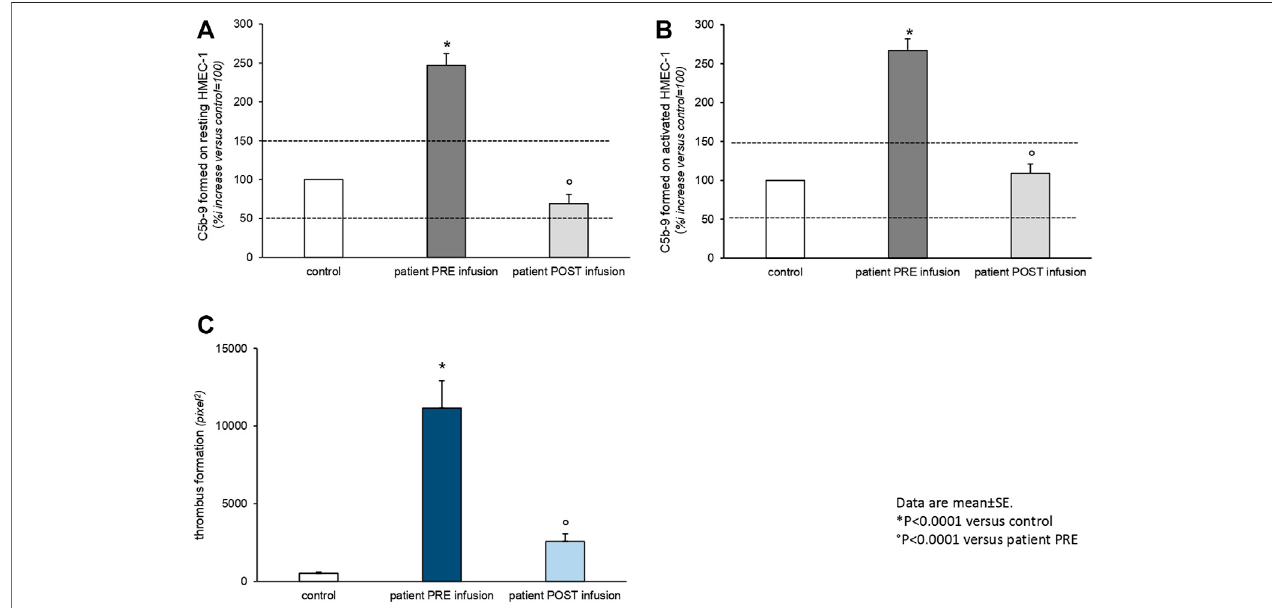
FIGURE 2 | Ex vivo C5b-9 deposition (A,B) and thrombus formation (C) on the cultured human microvascular endothelial cell (HMEC-1) line induced by serum of Patient2collectedbefore(PREinfusion)and10 daysafter(POSTinfusion)eculizumabtreatment. (A,B) .HMEC-1resting (A) oractivatedwithADP (B) wereincubatedfor 2 hwithserum(diluted1:2withtest medium,HBSS with0.5%BSA)fromthepatient orwithacontrolserum pool. Attheendofincubation, thecellswerewashed, fi xed, and stained with rabbit anti-human complement C5b-9 complex antibody followed by the FITC-conjugated secondary antibody. Fluorescence microscopy was used to view the fl uorescent staining on the endothelial cell surface, and the HMEC-1 area covered by C5b-9 staining was calculated by automatic edge detection (ImageJsoftware)in15high-power fi elds.Foreachsample,thehighestandlowestvalueswerediscarded,andthemeanoftheother13 fi eldswascalculatedandvalues wereexpressedasthepercentageofC5b-9depositsinducedbyapoolofserafrom10healthycontrolsruninparallel(reference100%).Dashedlinesindicatetheupper andlowerlimitofnormalrange. (C) HMEC-1wereactivatedwithADPandexposedfor2 htoserum(diluted1:2withtestmedium,HBSSwith0.5%BSA)fromthepatient or with a control serum pool. Perfusion of heparinized whole blood (heparin 10 U/ml) from a healthy subject (added with the fl uorescent dye mepacrine 10 µM, to label platelets) was then performed in a thermostatic fl ow chamber (37 ° C) in which one surface of the perfusion channel was a glass slide seeded with a monolayer of endothelialcellsataconstant fl owrateof1,500s − 1 (60 dynes/cm 2 ).After3-minperfusionwasstopped,theslidewiththeendothelialcellmonolayerwasdehydratedand fi xed in acetone for 20 min. The slides were examined under a confocal inverted laser microscope. Fifteen fi elds for each slide were systematically digitized along the surface, and the area covered by thrombi was quanti fi ed by ImageJ (NIH, Bethesda, MD) and expressed as pixel 2 per fi eld analyzed. For each sample, the mean of 15 fi elds (excluding the lowest and the highest values) was calculated. Data are reported ±SE. * p < 0.0001 versus control serum pool; p < 0.0001 versus patient PRE infusion. Statistical analysis: